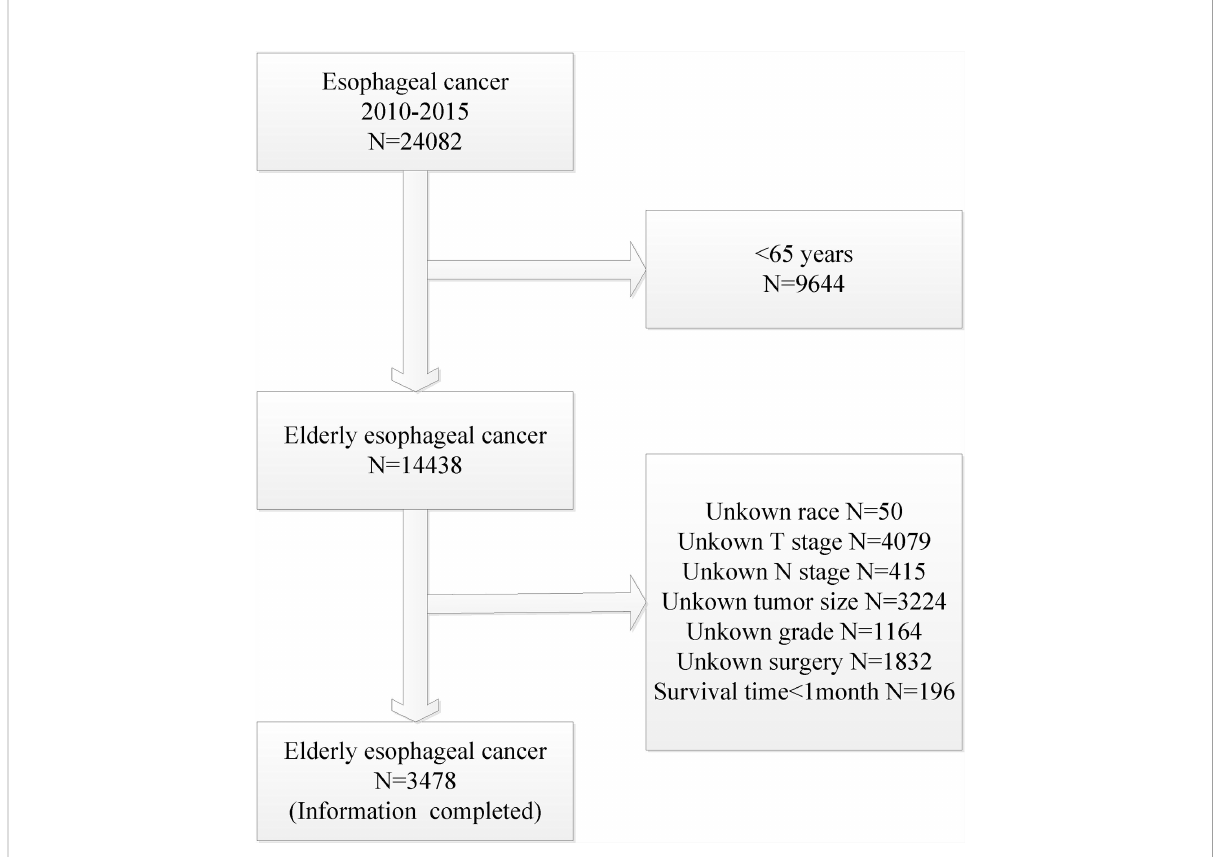
FIGURE 1 Flow diagram of selecting